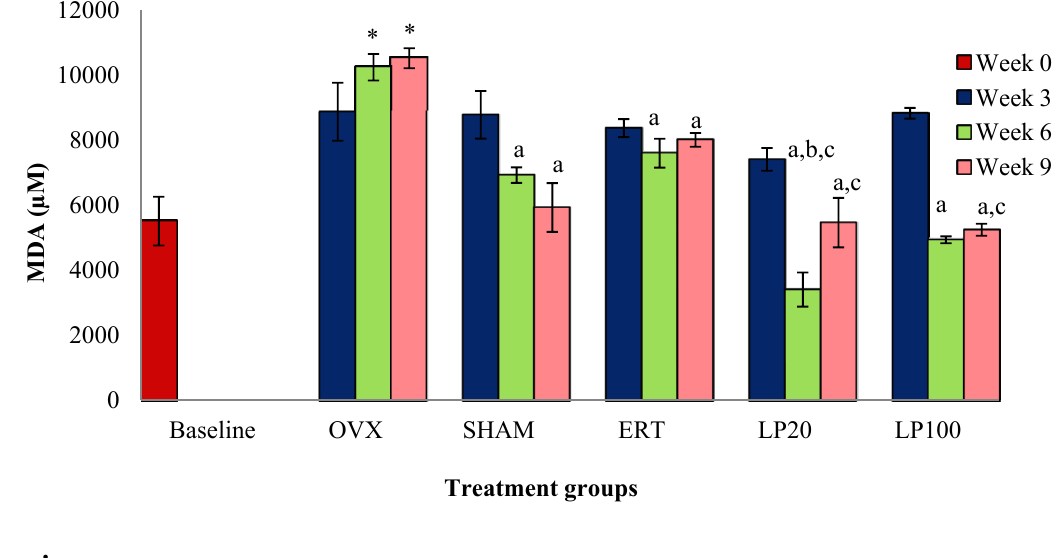
Figure 3. Mean melondialdehyde concentration for all the groups after 3, 6 and 9 weeks of treatment. Data presented mean ± SEM ( p < 0.05). SHAM: sham-operated, OVX: ovariectomized control, ERT: ovariectomized and estrogen supplementation, LP20: ovariectomized and supplemented with LP at the dose of 20 mg/kg, LP100: ovariectomized and supplemented with LP at the dose of 100 mg/kg. * p < 0.05 versus Baseline; a p < 0.05 versus OVX at the corresponding weeks; b p < 0.05 versus SHAM at week 6; c p < 0.05 versus ERT at the corresponding